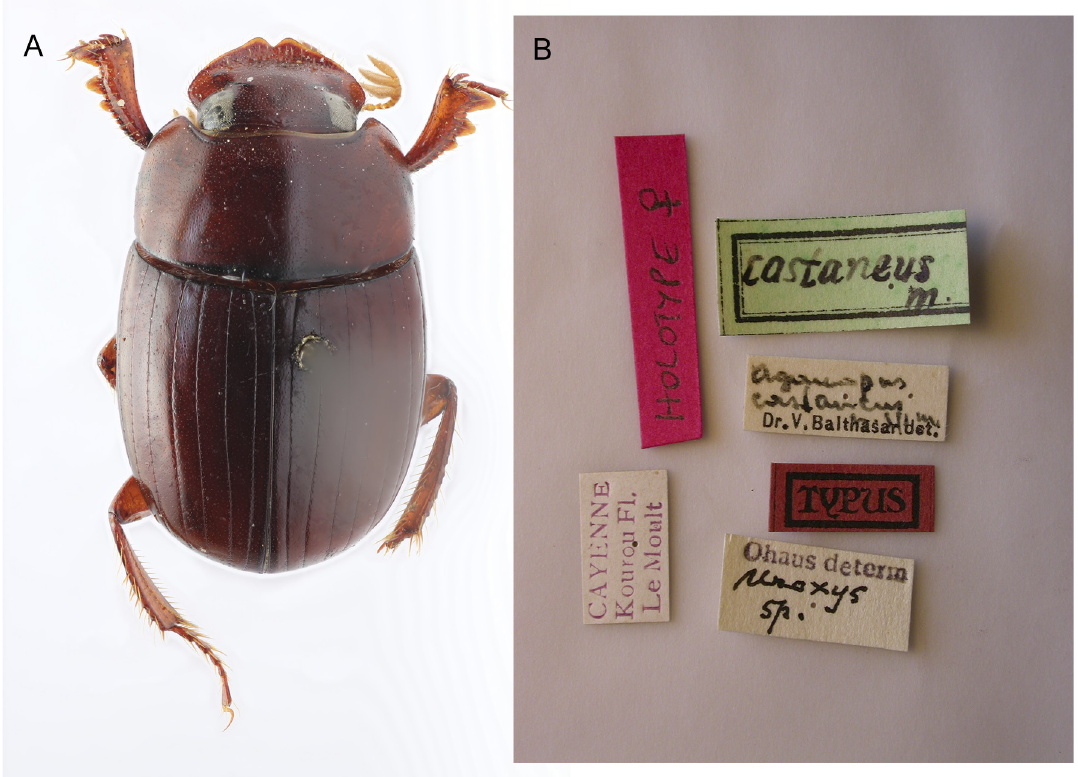
Fig. 1. Agamopus castaneus Balthasar, 1938. Holotype, ♀ (NMPC). A . Habitus, dorsal view. B . Labels. Length of specimen: 6.5 mm. Photographs: Jiří Hájek,